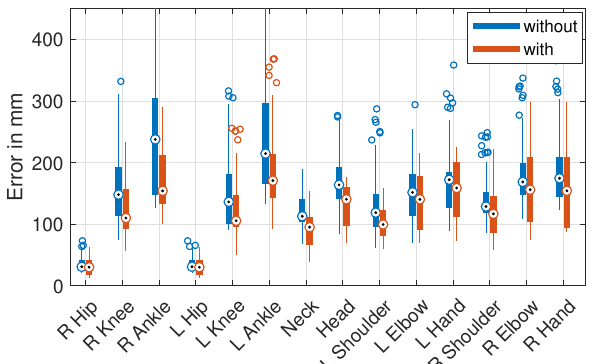
Figure 5. Jointwise error of all cross-dataset results with and without scale normalization. Box plot with median (circle with dot), 1’st/3’rd quartile (bottom/top of thick bar), and outliers (circles, default settings of MATLAB 2017b).